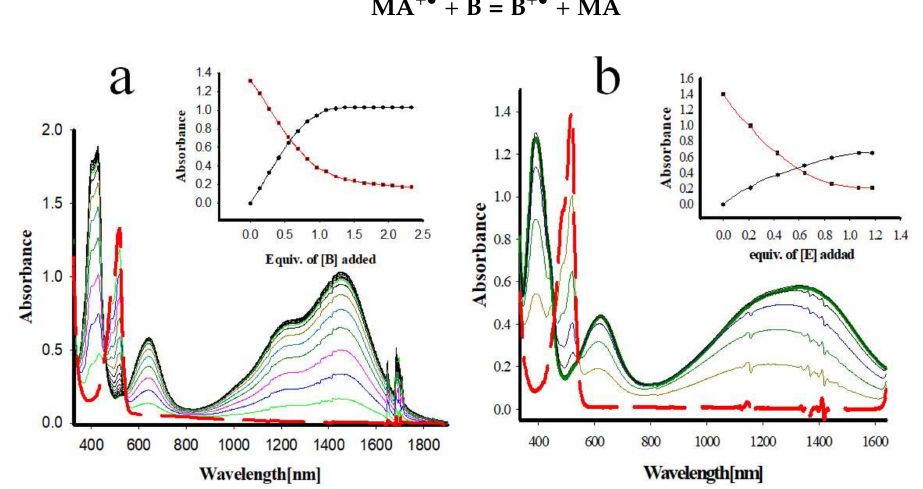
Figure 4. ( a ) Spectral changes upon the reduction of 1.8 × 10 − 4 M MA + • (red dashed line)